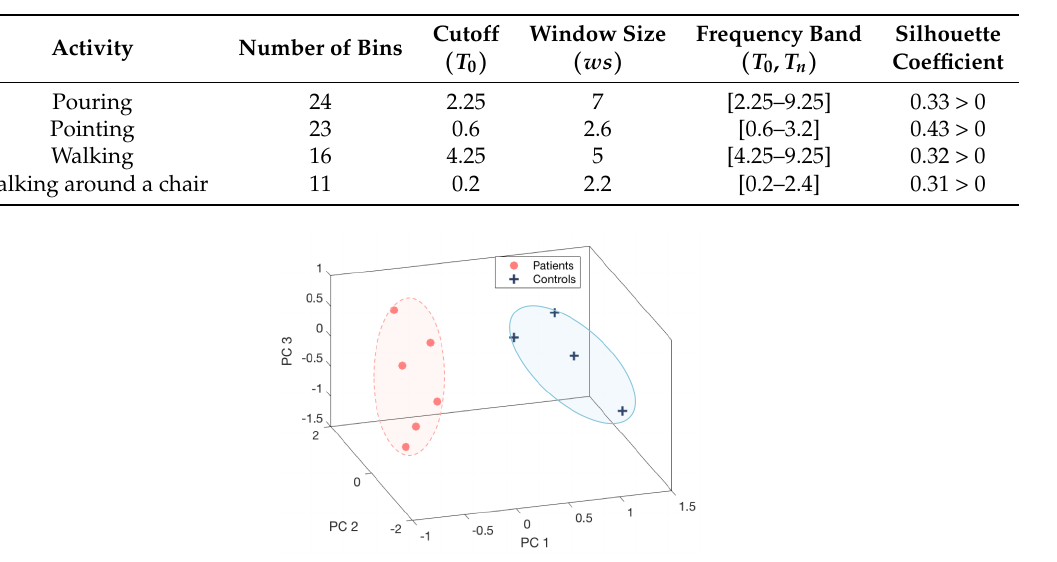
Table 3. Optimised parameters for Sensor 2 vs. 4 combination.